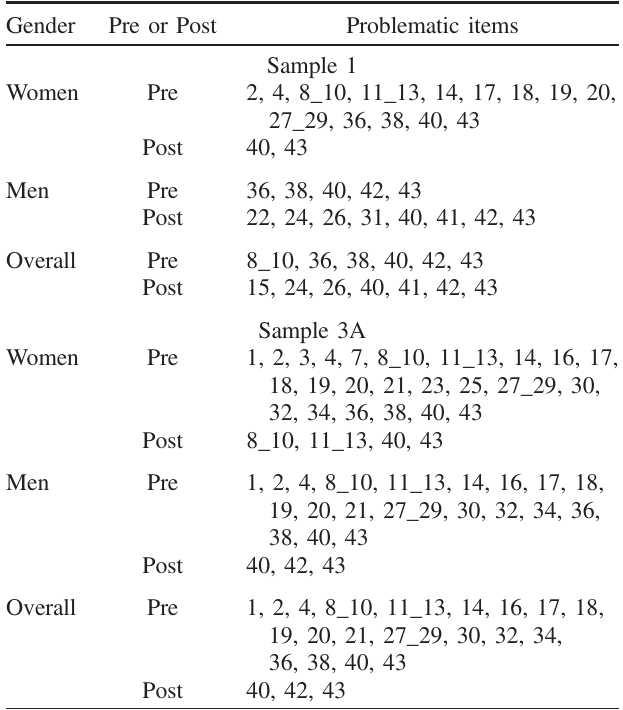
D < 0 . 2 for the FMCE. Gender Pre or Post Problematic items